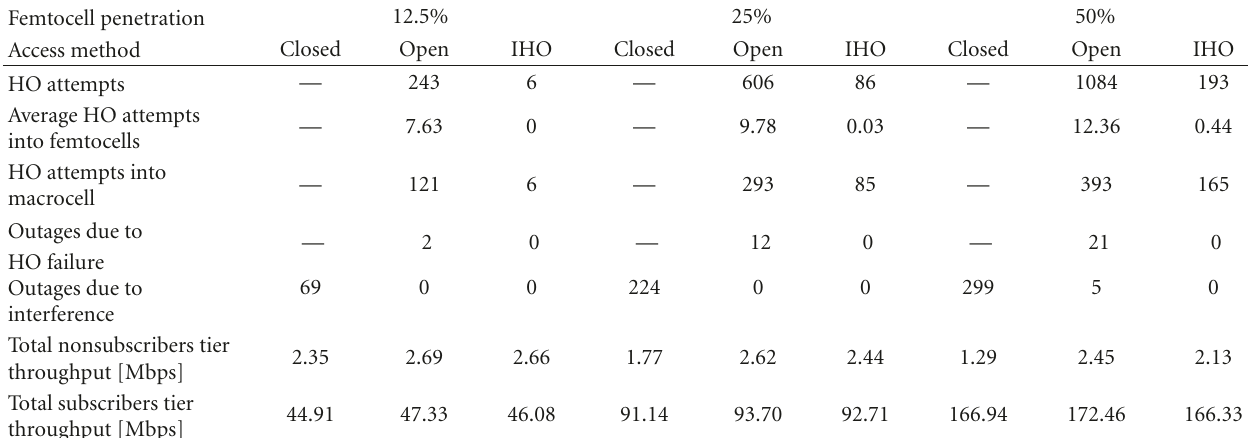
Table 6: Performance comparison for Setup 1 (800 s simulation).